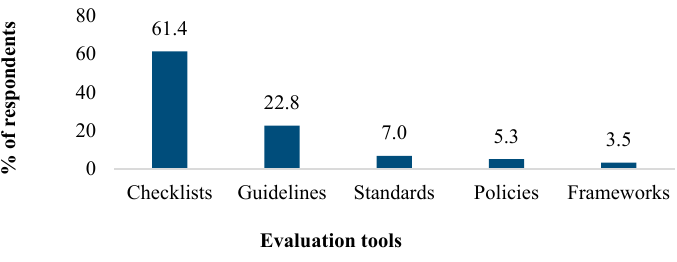
Figure 4. Tools used in evaluating Cloud BI and IT solutions.